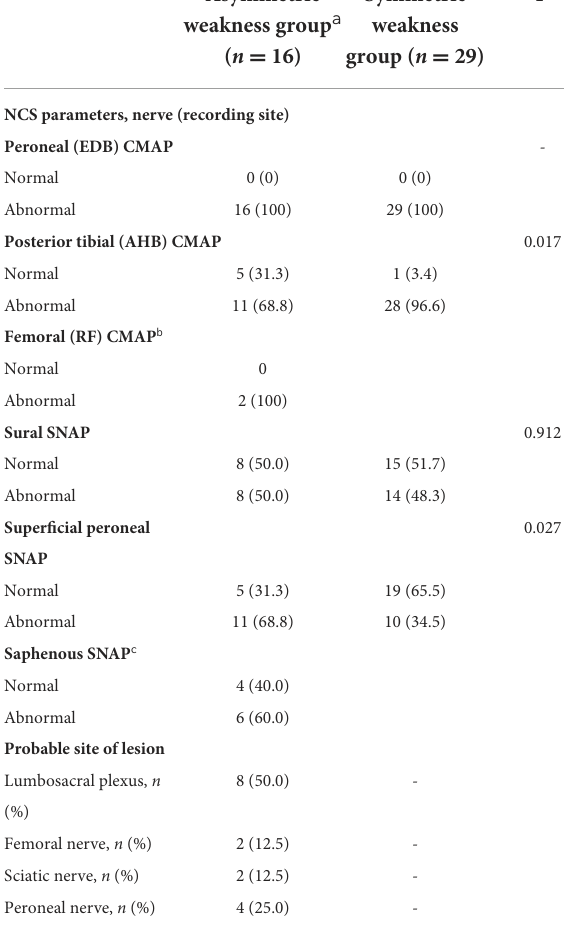
TABLE 3 Electrodiagnostic features of patients who developed leg weakness after lung transplantation.